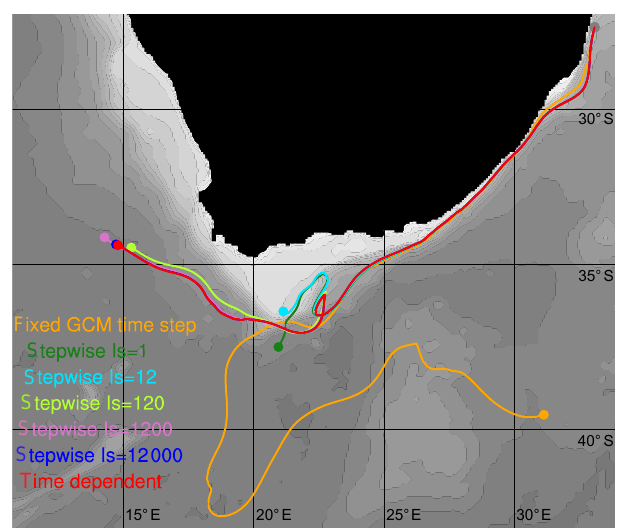
Figure 6. Example of ocean trajectory paths due to different tra- jectory schemes and number of intermediate time steps. The time- dependent method results are in red as well as those obtained with the stepwise-stationary method with I S = 1 , 12 , 120 , 1200 and 12000 as well as fixed GCM time steps. Note that these homolo- gous trajectories were selected to illustrate that stepwise-stationary trajectories are closer to time-dependent trajectories when the num- ber of intermediate time steps (I S ) is